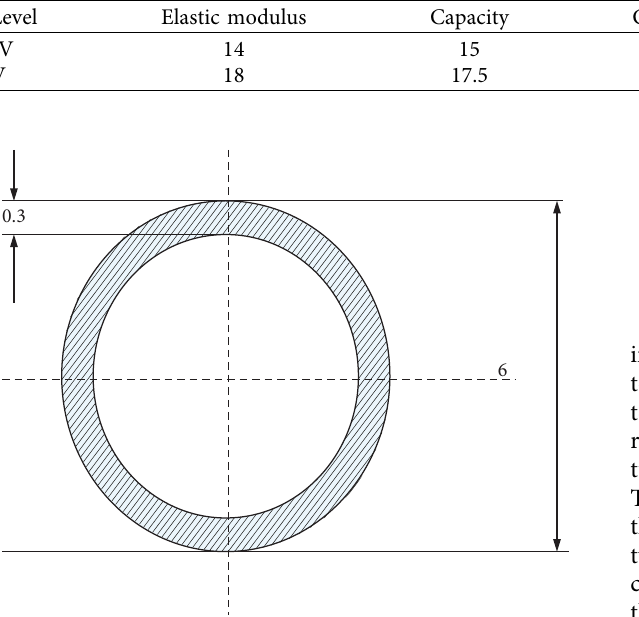
Figure 5: Sectional view of the lining structure of a shield